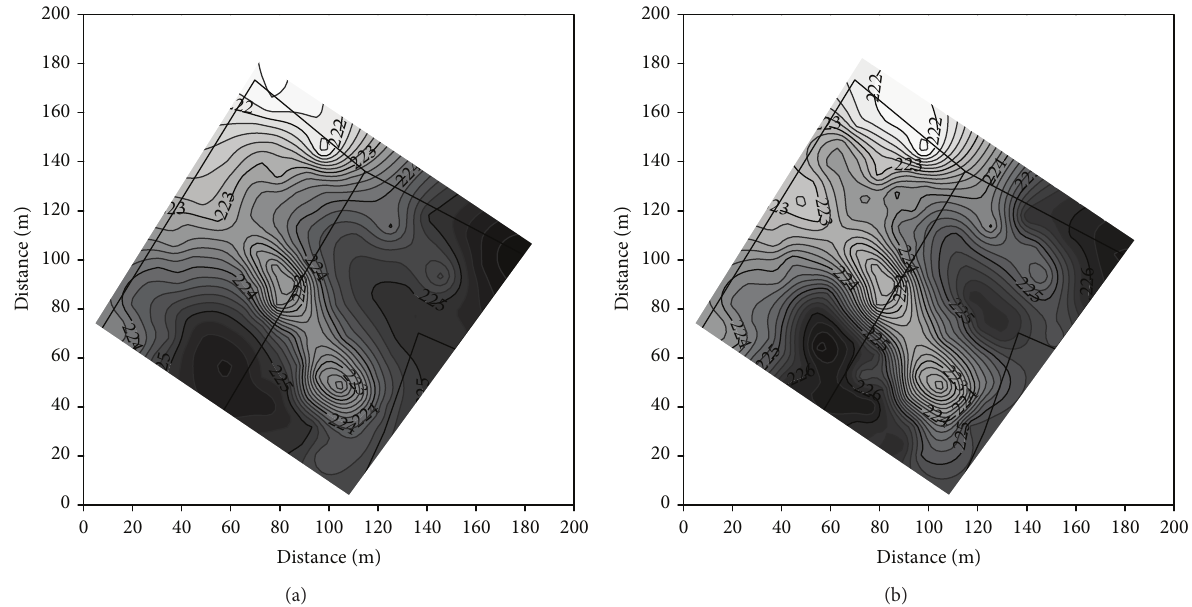
Figure 6: Topography of studied area without accumulated soil material (a) and the past relief (b).